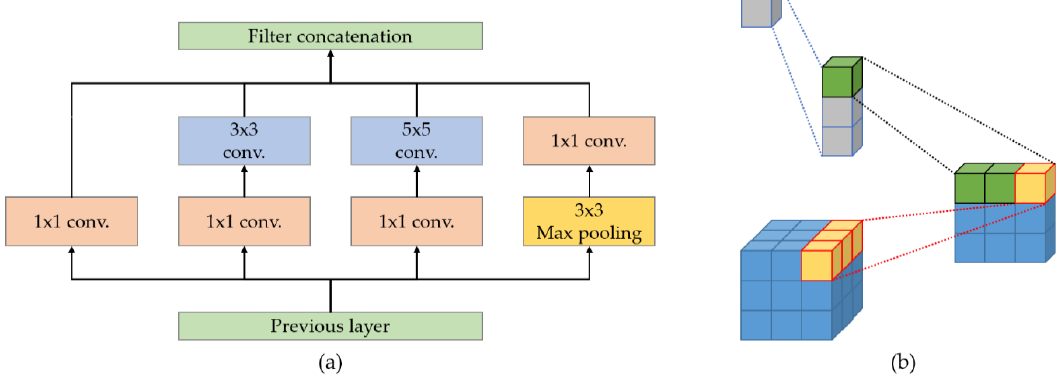
Figure 12. 3D convolution filter with Inception structure. ( a ) The architecture of GoogLeNet Inception; ( b ) Decomposition principle of convolution filter using Inception structure.